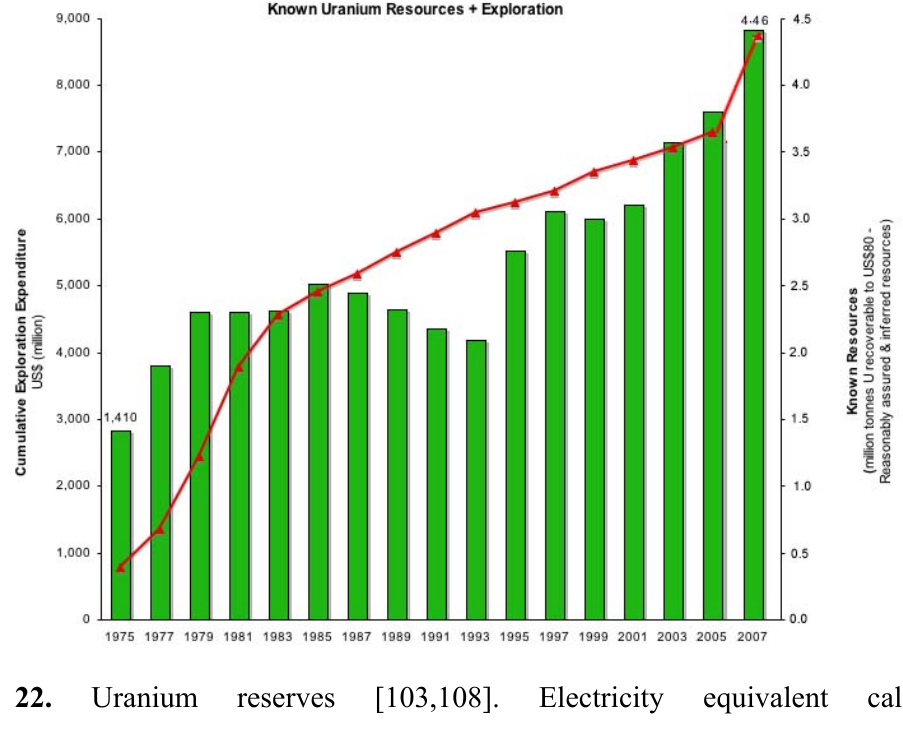
Figure 21. Uranium exploration expenditure and RAR+inferred resources < US$80/t (from [107]). RAR+inferred resources < US$130/t are 5.5 MtU ([96]).